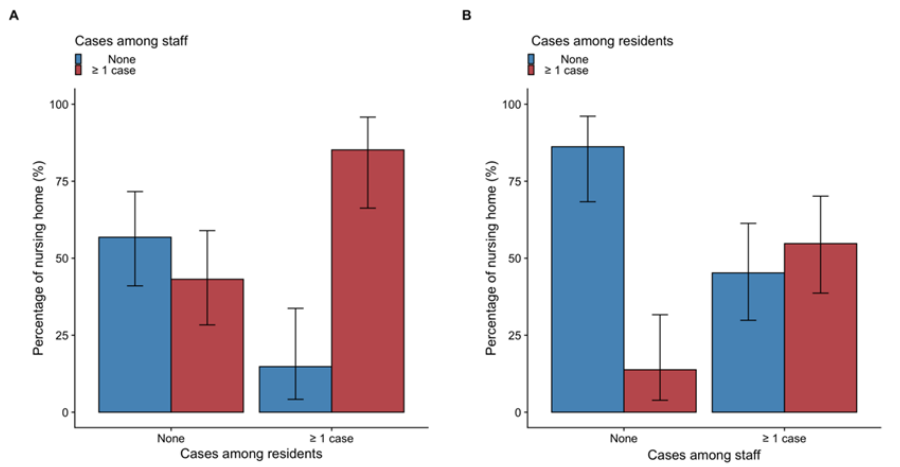
Figure 2. Relationship between COVID-19 cases either in nursing home residents or staff members and the occurrence of case among staff members or the residents. ( Panel A ) represents the frequency of nursing homes with ≥ 1 cases among its staff members according to the occurrence of ≥ 1 cases among its residents. ( Panel B ) represents the frequency of nursing homes with ≥ 1 cases among the residents according to the occurrence of ≥ 1 cases among its staff. Very few nursing homes had cases among their residents without having at least one case among staff members. Table 3. Associations between nursing home characteristics and the occurrence of outbreaks ≥ 3 cases among the residents, adjusted on the occurrence of cases ≥ 1 among the